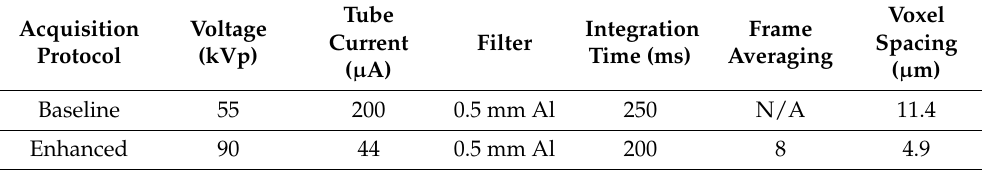
Table 1. Summary of µ CT acquisition parameters for baseline and enhanced protocols for visualiza- tion of BaSO 4 -labeled microdamage in rat vertebral